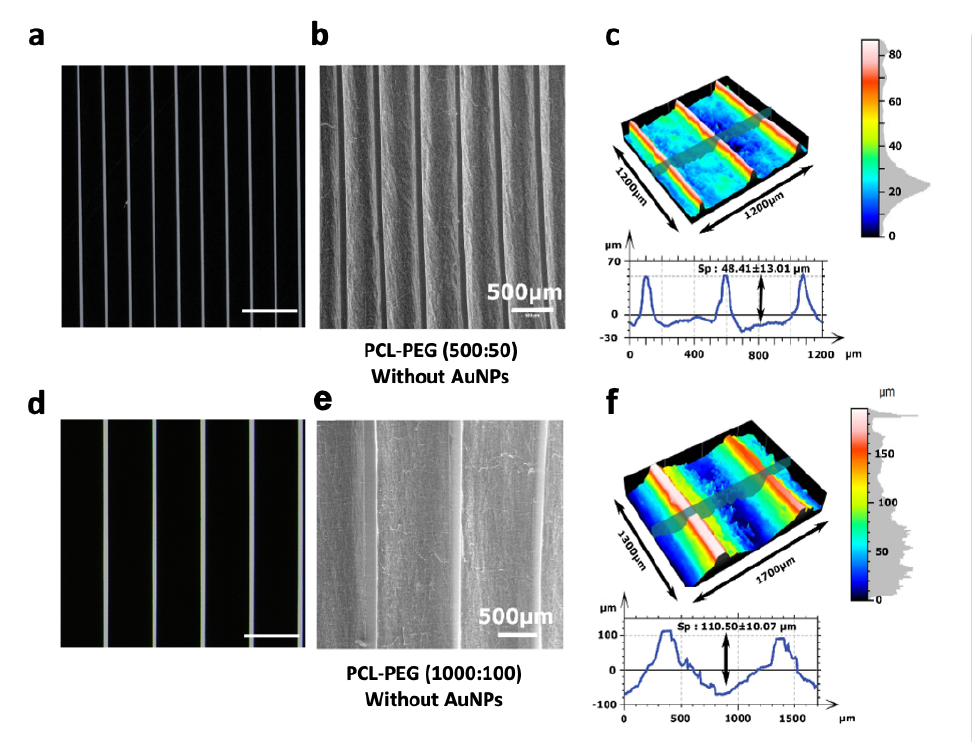
Figure 4. Characterization of the micropatterning of the scaffolds. ( a , d ) Images of the mask used for the photolithography of 50 µm and 100 µm PEG lines. ( b , e ) SEM images of line micropatterns with a spacing of 500 µm and 1000 µm respectively, on an electrospun mat. ( c , f ) Sensofar optical profiler measurements of the surface topography, height and thickness of the hydrogel line. Scale bar of panels ( a , d ) represents 1 mm and that of panels ( b , e ) 500